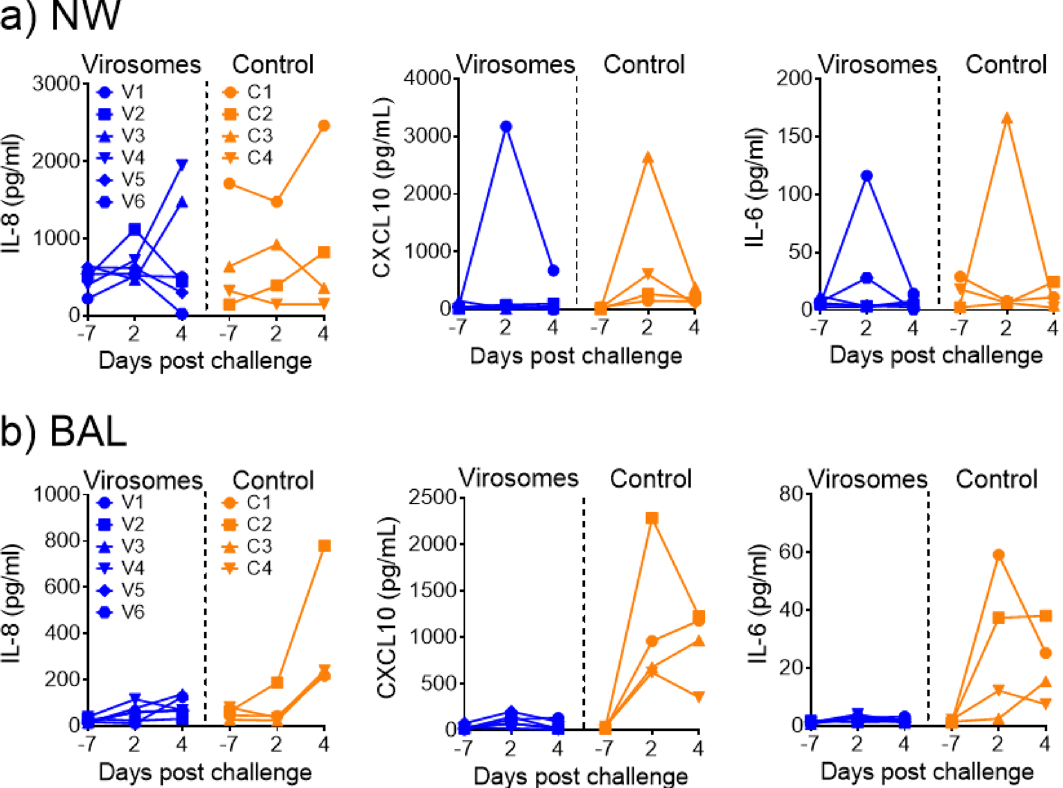
Figure 6. Control of SARS-CoV-2-induced cytokine storm in BAL fluids, but not in nasal washes, after intramuscular virosomes-RBD vaccination. Pro-inflammatory cytokine levels of IL-8, CXCL10 and IL-6 in ( a ) nasal washes (NW) and ( b ) BAL fluid of virosomes-RBD immunized (blue) and control (orange) animals. All data are shown relative to the day of challenge (day 0). Levels in each individual animal (indicated by different symbols) in time are shown. No measurements were performed on day of challenge, but data obtained at day 7 before challenge are